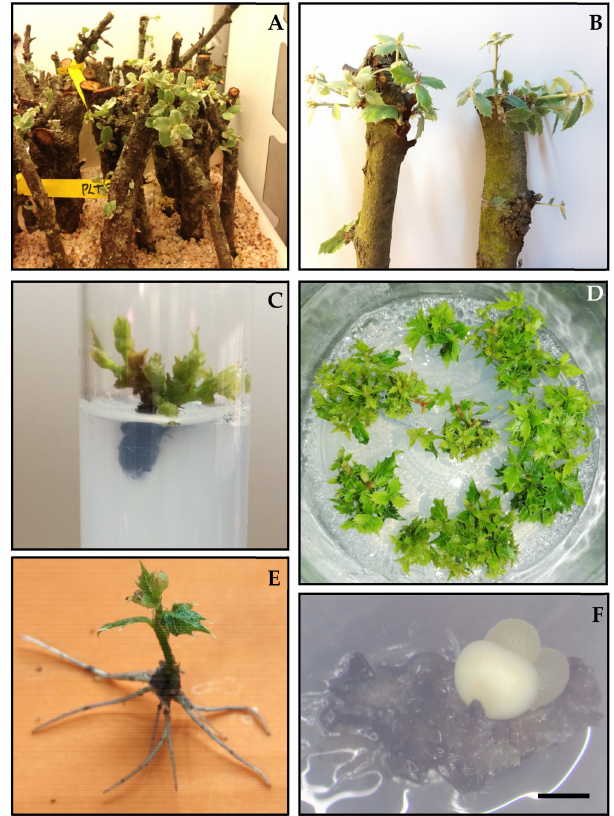
Figure 1. Micropropagation of adult holm oak trees selected for their ability to grow in disease hotspots. ( A , B ) Forced flushing of branch segments from trees from the south-west area ( A ) and Mediterranean area ( B ) in a climate chamber. ( C ) Shoot development from a nodal explant collected from a forced branch shoot 8 weeks after initial culture. Tube diameter: 30 mm. ( D ) Appearance of shoot cultures after 6 weeks on proliferation medium. Jar diameter: 90 mm. ( E ) Rooted shoot of clone VA5 after culture for 48 h on the rooting medium supplemented with IBA 25 mg L − 1 and 6 weeks on rooting medium without plant growth regulators. ( F ) Induction of somatic embryos from an